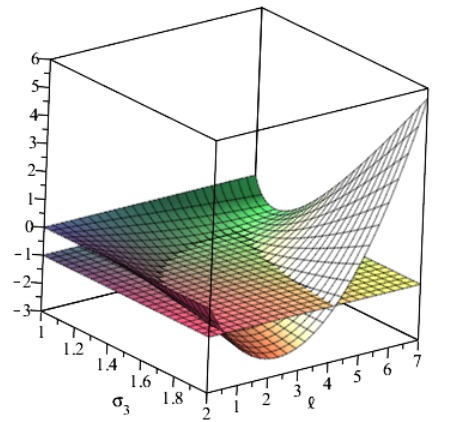
Figure 3 . A di(cid:11)erent view. Comparison between the lowest eigenvalue of R 2 bound, which is -1 in this case, as a function of ‘ and (cid:27) 3 , for (cid:28) 3 = 9 for values of (cid:27) 3 close to 1, which correspond to large values for the ratio R 2 values of V 0